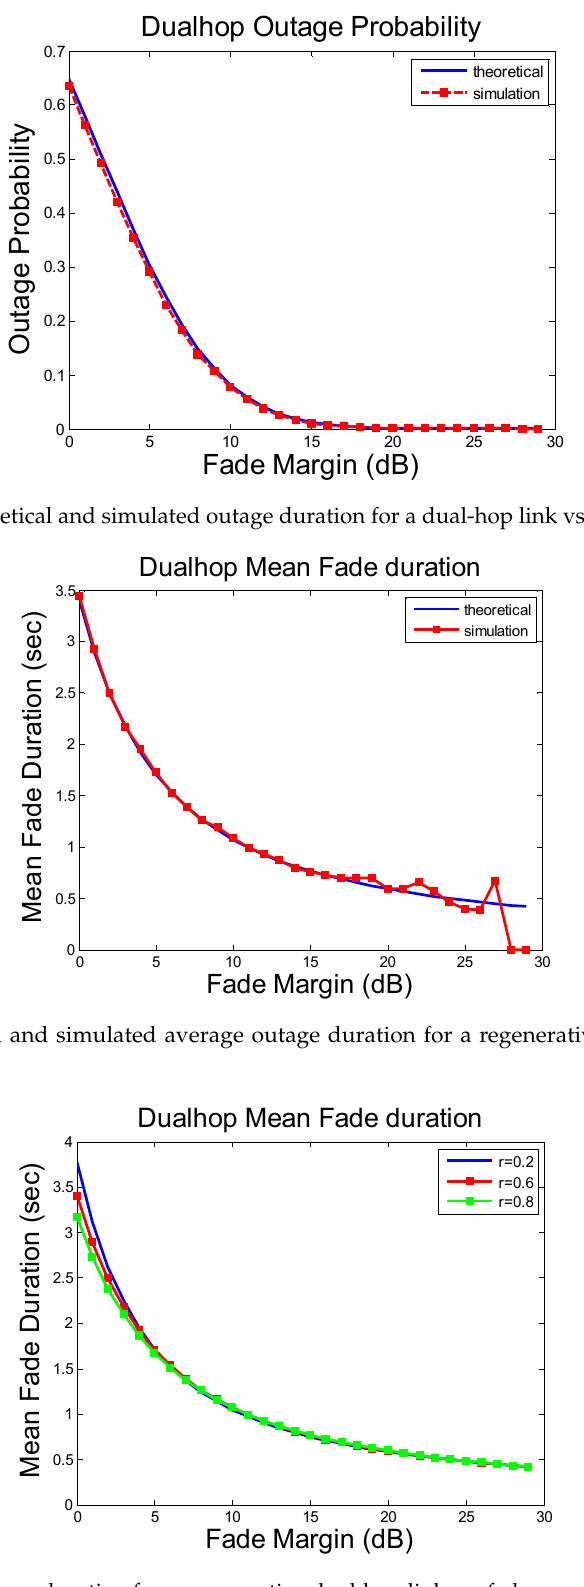
Figure 5. Average outage duration for a regenerative dual-hop link vs. fade margin for three different values of shadowing correlation coefficient.